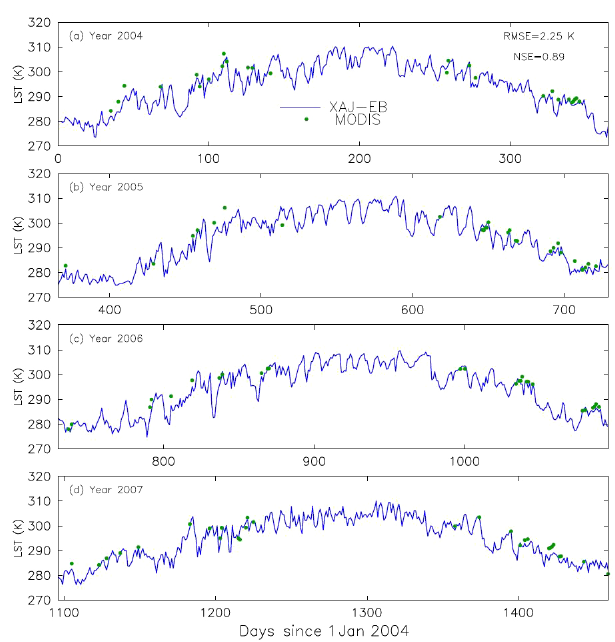
Figure 8. Time series of modeled catchment-average land surface temperature for the period between 1 January 2004–31 Decem- ber 2007. The MODIS-retrieved catchment-average land surface temperature (LST) is also shown when the data availability ex- ceeded the threshold (see Sect. 3 for details).